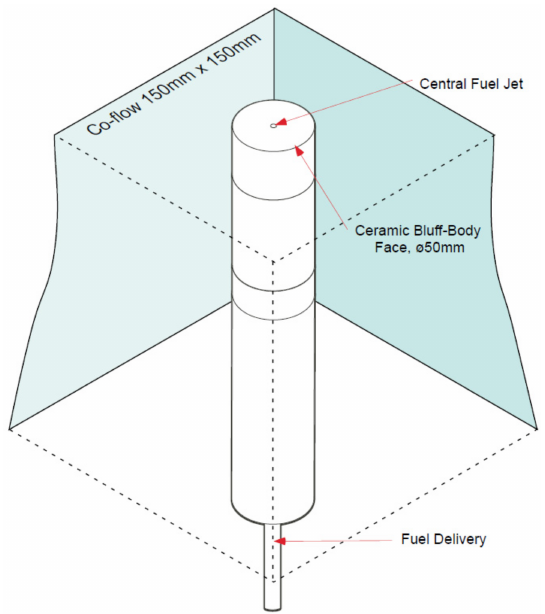
Figure 1. Sydney University bluff-body burner schematic [15].